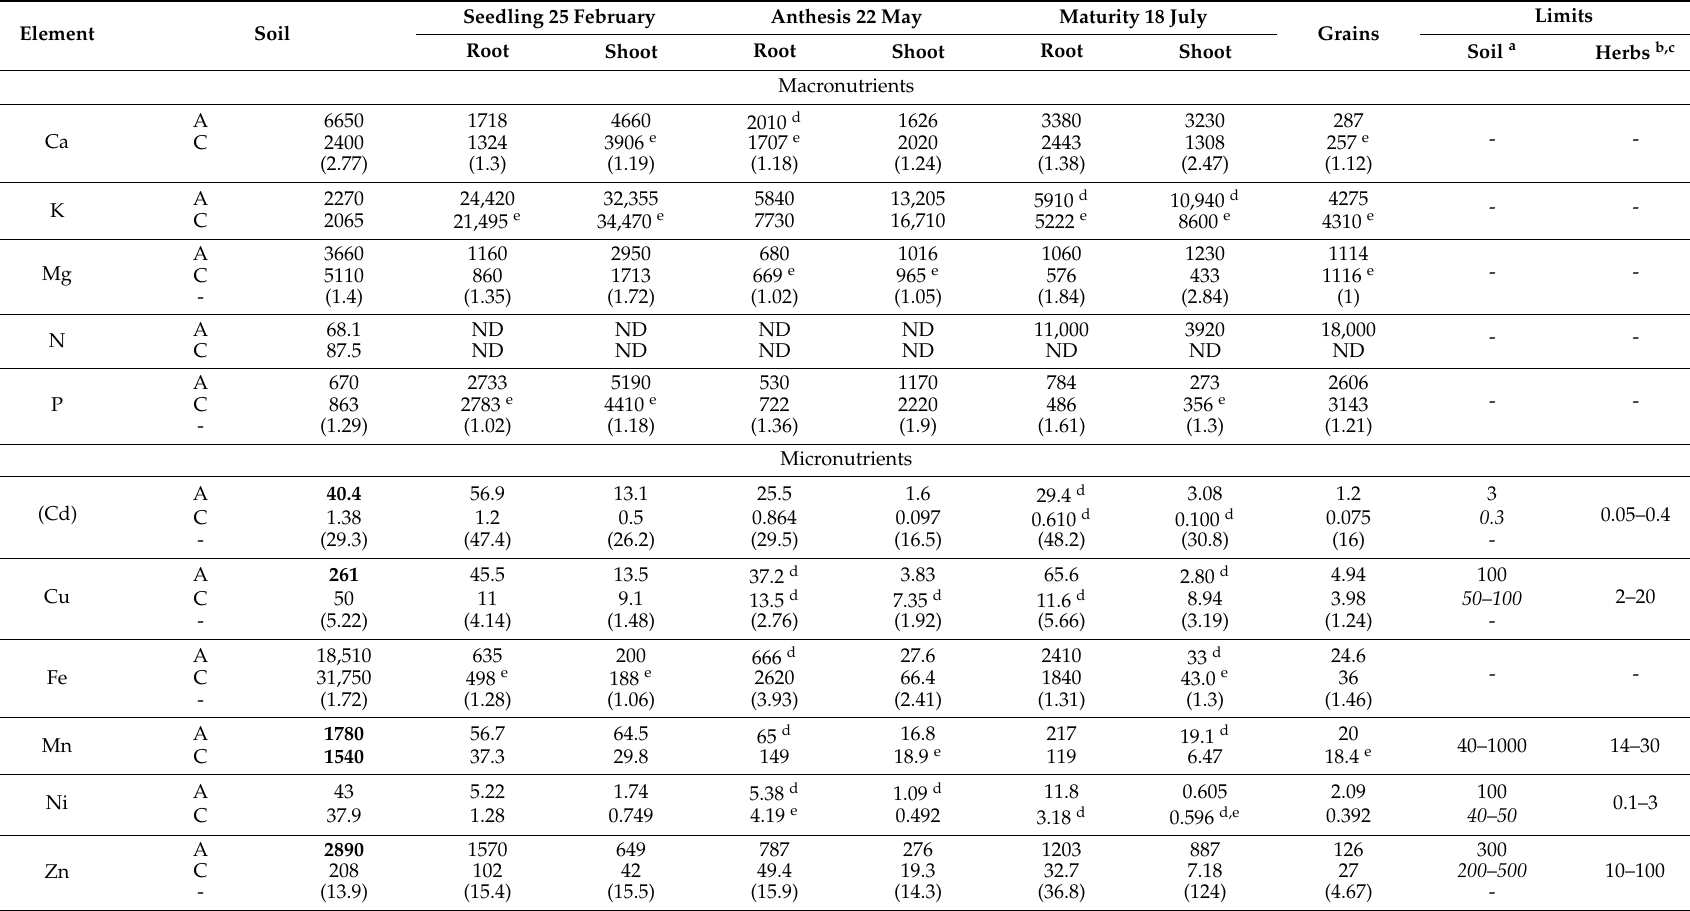
Table 1. Evolution of the mineral concentrations in roots, shoots, and grains (mg · kg − 1 · dry weight (DW)) of wheat cv. JB Asano grown on the metalliferous soil (A) and the reference soil (C) from the seedling state via anthesis to maturity. In parentheses, the concentrations of the individual elements in the soil A- to soil C-grown plant tissues are expressed as quotients from high:low values. Note the recommended concentration limits for arable soil, herbage, and food grains.